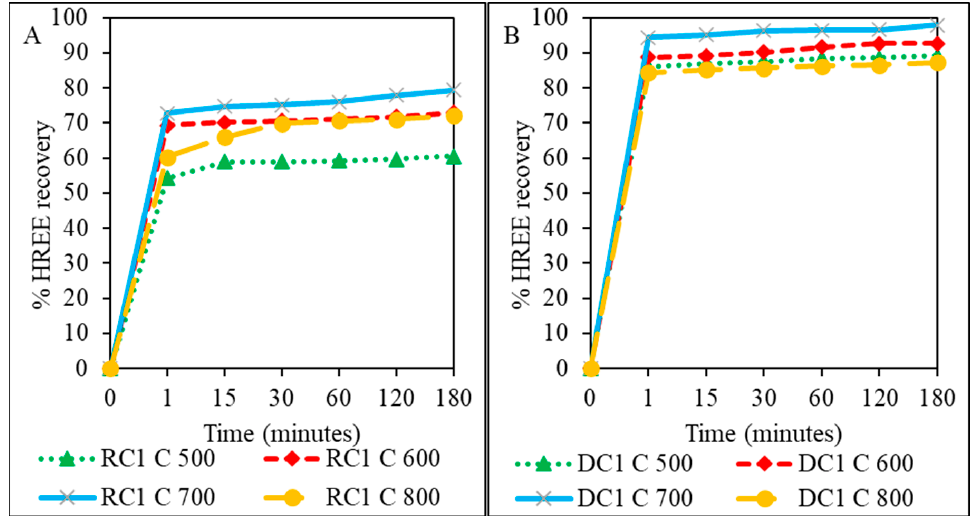
Figure 9. Calcined RC1 ( A ) and DC1 ( B ) % HREE leaching recovery under the optimised leaching parameters of (HCl concentration of 2 M, solid:liquid ratio of 10 g/L, leaching temperature of 50 °C, D 90 = − 106 μ m, stirrer speed 550 rpm).